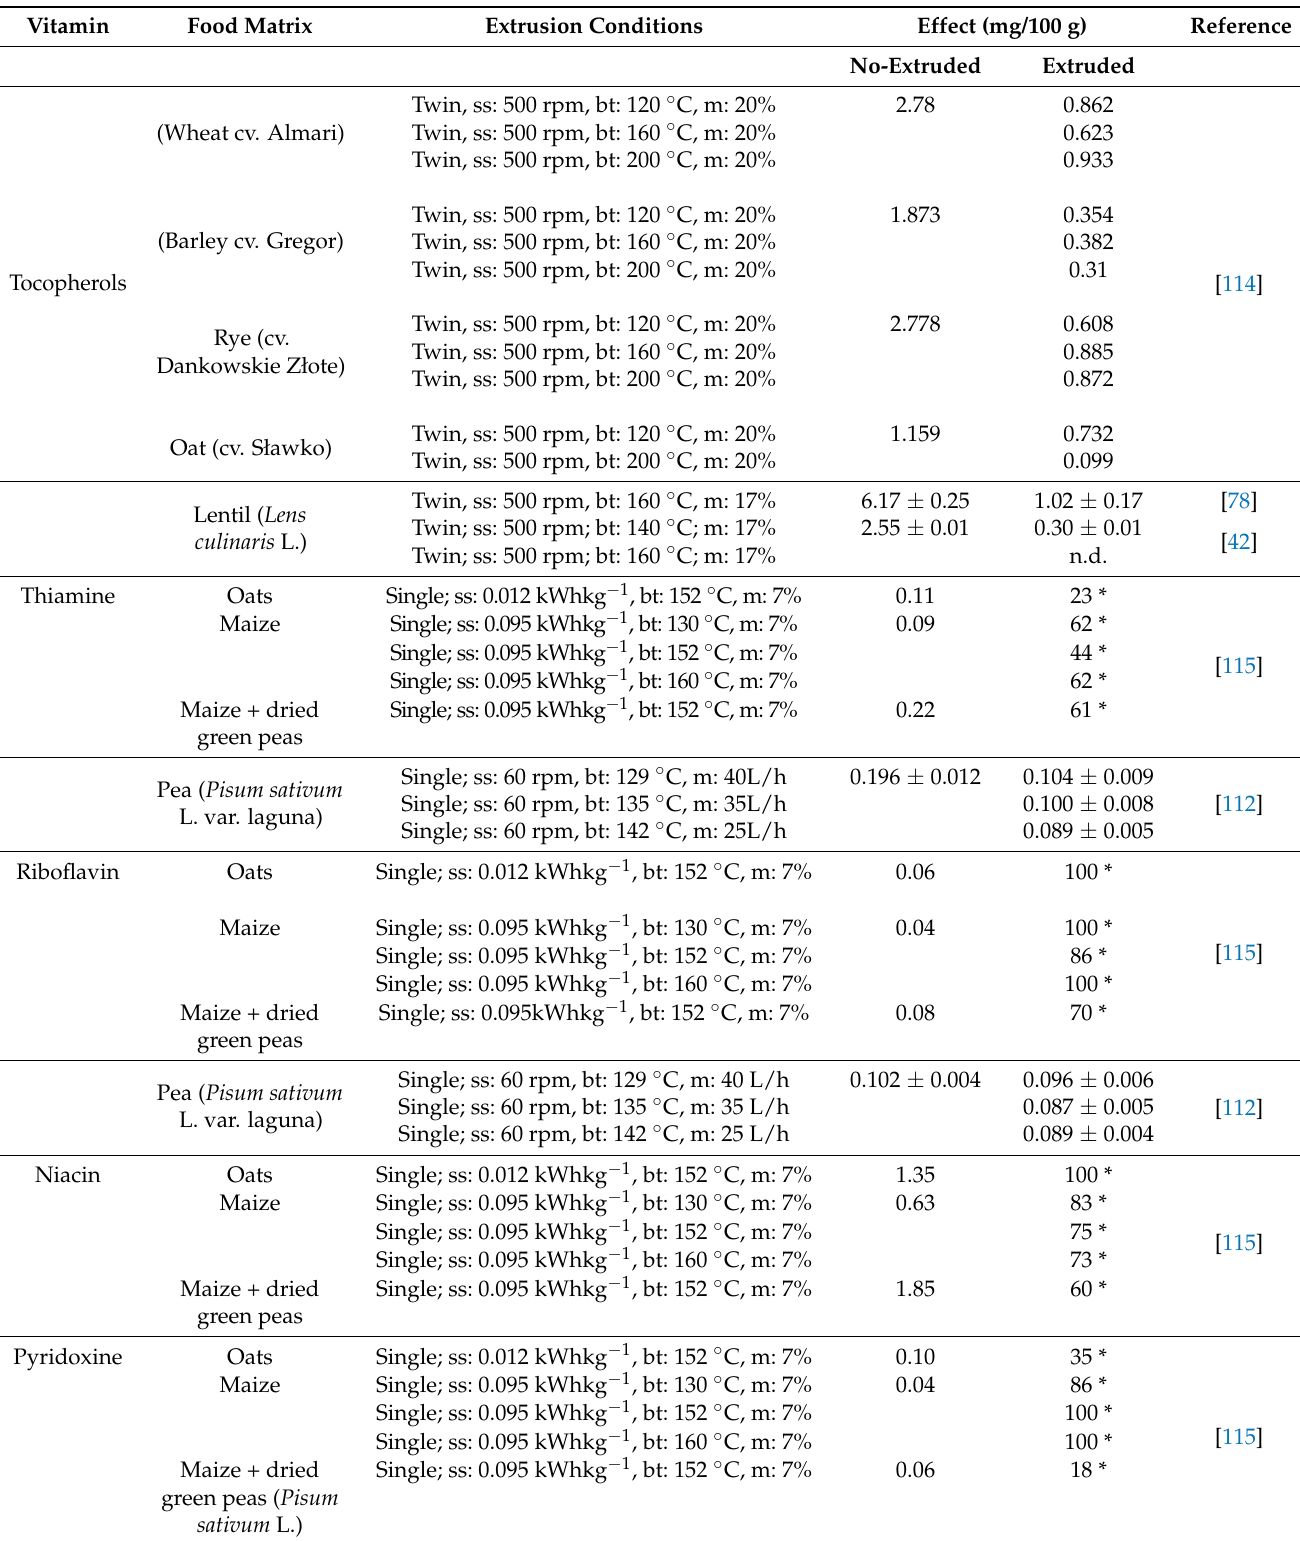
Table 5. Effect of extrusion processing conditions on the vitamins content of pulse and cereal extrudates. Vitamin Food Matrix Extrusion Conditions Effect (mg/100